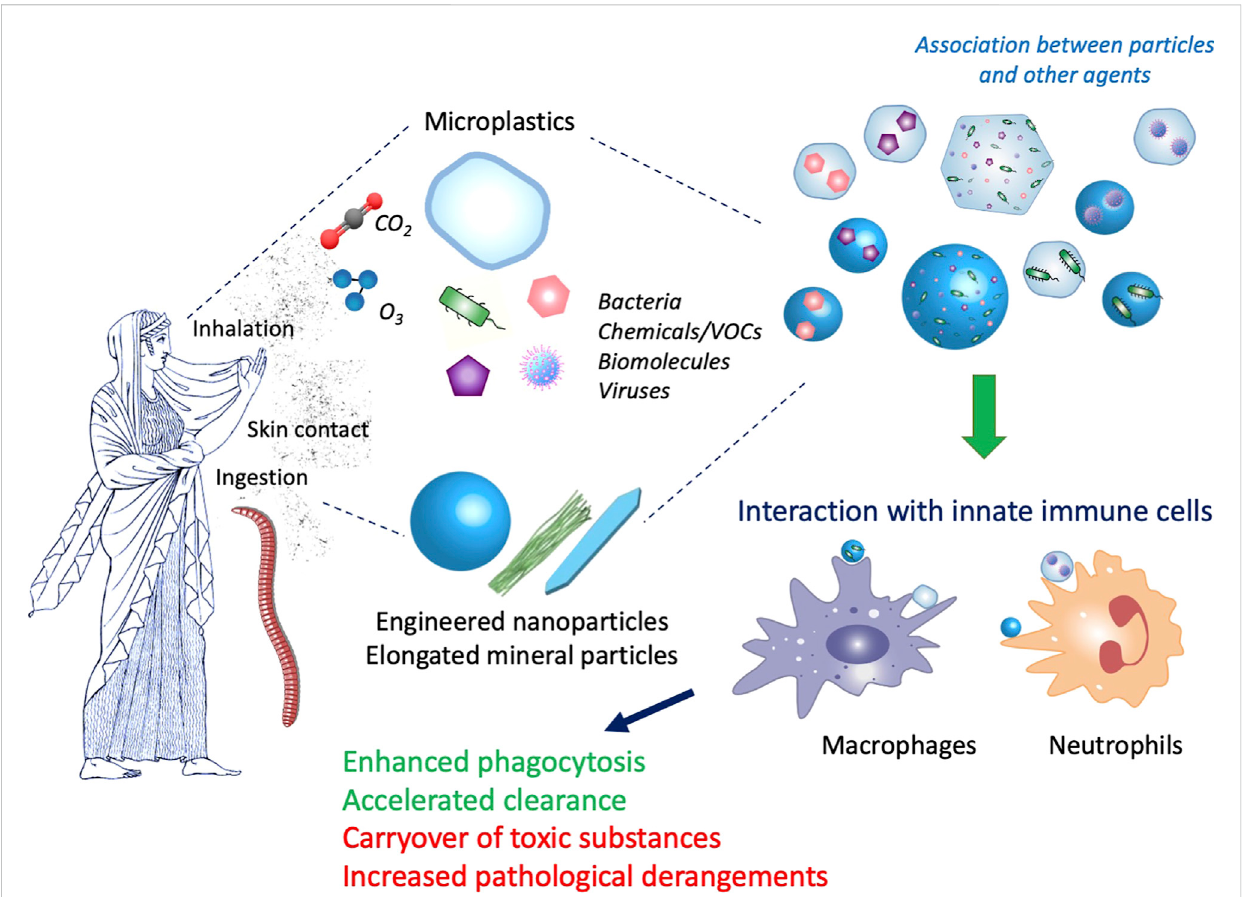
FIGURE 1 Interaction between particles and contaminants and their effect on immunity. Both vertebrates and invertebrates can be exposed to particles present in the environment, mainly by ingestion, skin contact and inhalation. Micro- and nanoparticles, e.g., microplastics, engineered nanoparticles and elongatedmineralparticles,arepresentintheenvironmenttogetherwithmanyotheragents,suchasgases(O 3 ,CO 2 ),microorganisms(bacteria,viruses), chemicals (volatile organic compounds -VOCs-, synthesis residues, additives, environmental contaminants) and many different biomolecules (pollens, allergens, bacterial compounds). Depending on the particle characteristics and the environmental conditions, interaction can occur, thereby givingrisetohybridcomplexes.Innateimmunecells(macrophages,neutrophils)atthebarriersites(skin,lung,gut) fi rstcomeincontactwiththeparticle/ contaminant complexes and react to them. Depending on the immune conditions (such as CO 2 -dependent acidosis or hypoxia, chronic diseases, immunosuppression) and the nature of the complexes, the innate immune reaction can be successful (e.g., enhanced phagocytosis and clearance of particles and microorganisms) or unsuccessful and detrimental (e.g., increased toxicity due to concentration of toxicants, increased hyperreaction/ infectivity due to excessive exposure to allergens/infectious agents). Artwork by W. Yang